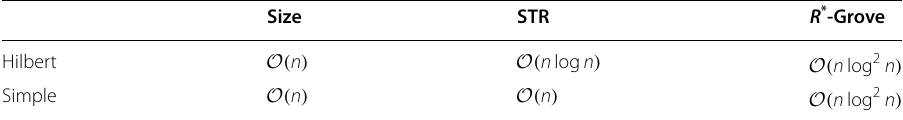
Table 2 Run time of spatial partitioning algorithms